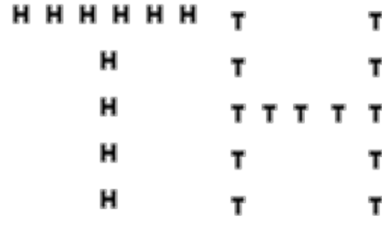
Figure 1. Traditional Navon letters.